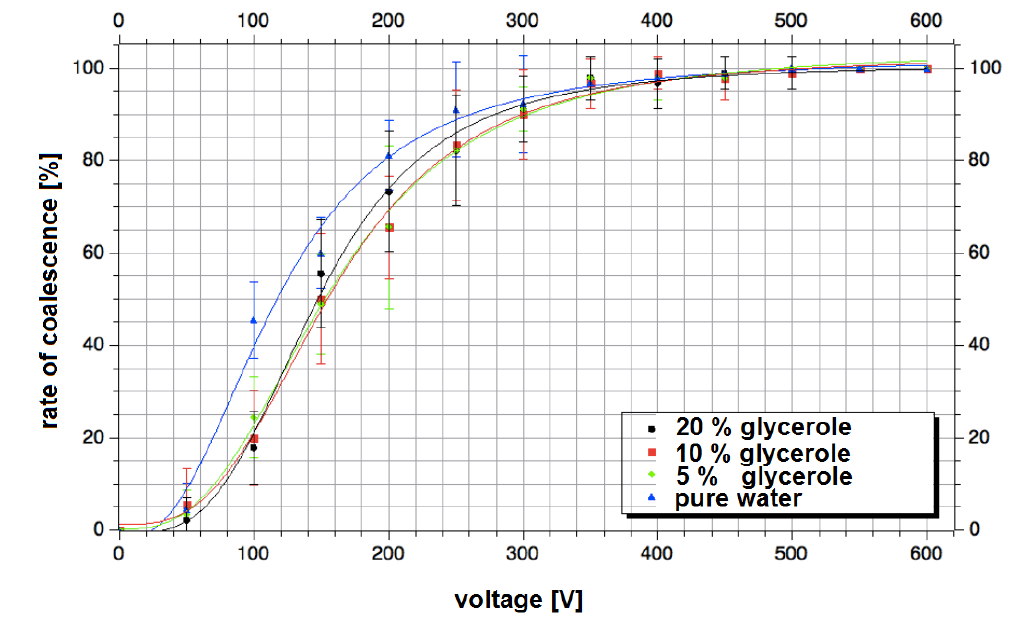
Figure 8. Coalescence rate in dependence of applied electrocoalescence voltage for different media. Water droplets with different glycerol content were delivered into the chamber. The electrocoalescence pulse interval was adjusted to the time need to fill the chamber with droplets. The number of coalesced droplets was determined by video analysis. The average coalescence rate was calculated for 100 repetitive coalescence events per spot.